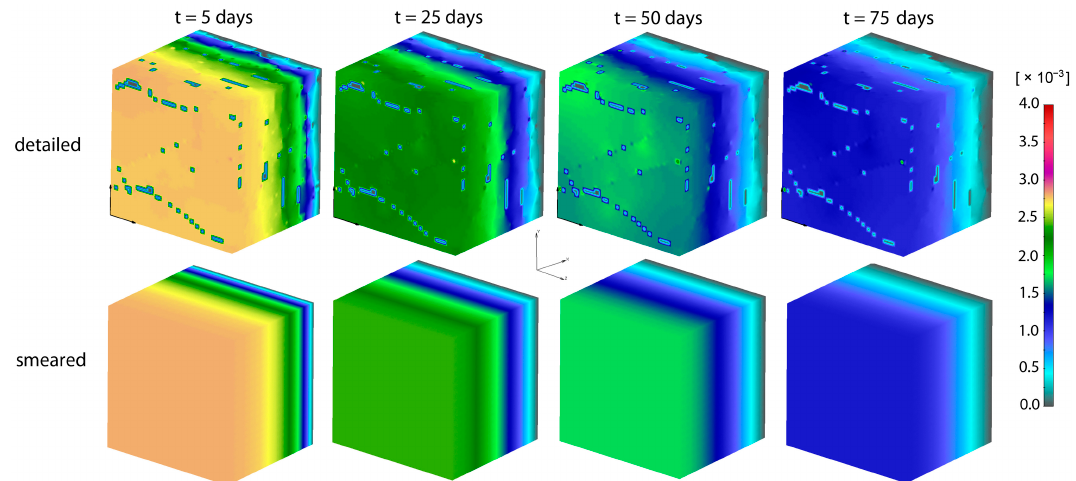
Figure 10. PLGA implant—concentration filed in the surrounding domain, for the detailed and smeared model, for the diffusion of Span-80/RhB complex within the PLGA implant.